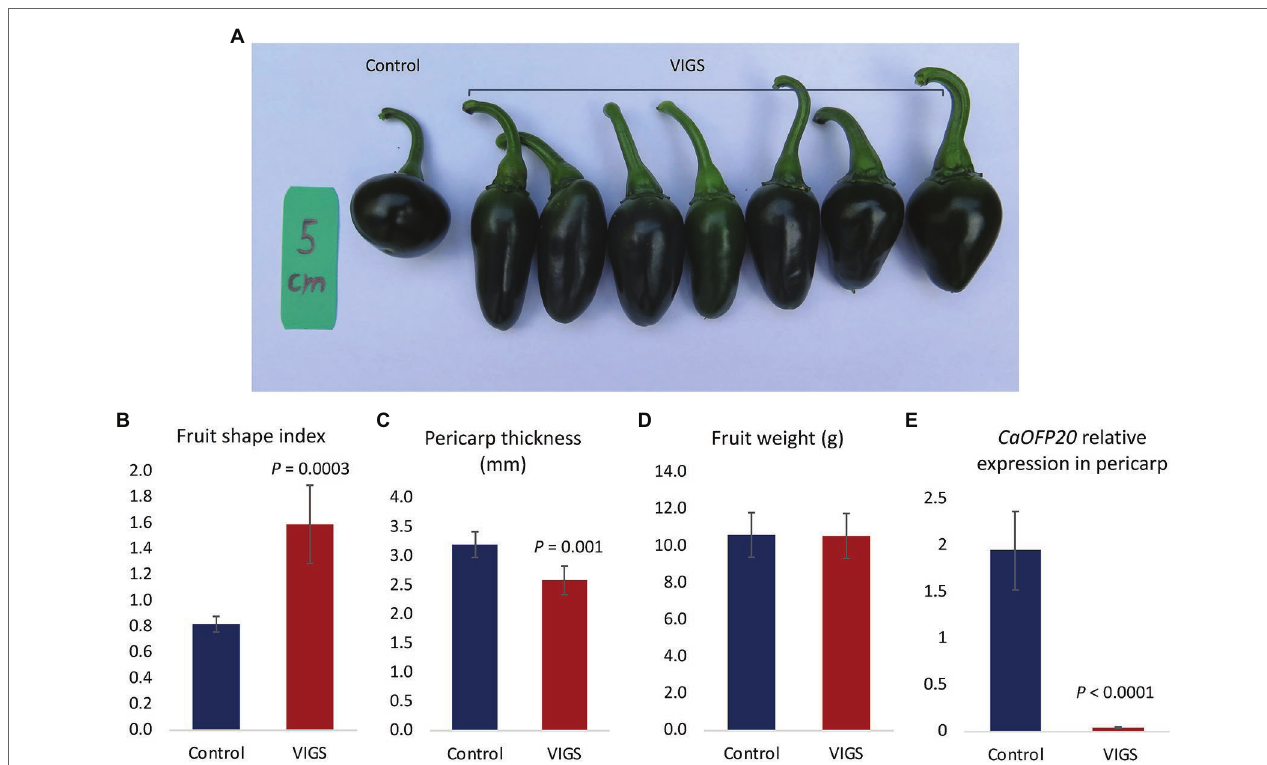
FIGURE 6 | Silencing of CaOFP20 in line 4590 by VIGS. (A) Silencing of CaOFP20 results in fruit elongation. Control – inoculation with empty vector. VIGS – examples of silenced fruit 3 weeks after anthesis. (B–D) Fruit shape index, pericarp thickness, and fruit weight of silenced and control fruit. (E) Expression of CaOFP20 is downregulated in silenced elongated fruit. Significant differences between the silenced and control fruit were determined by Student’s t